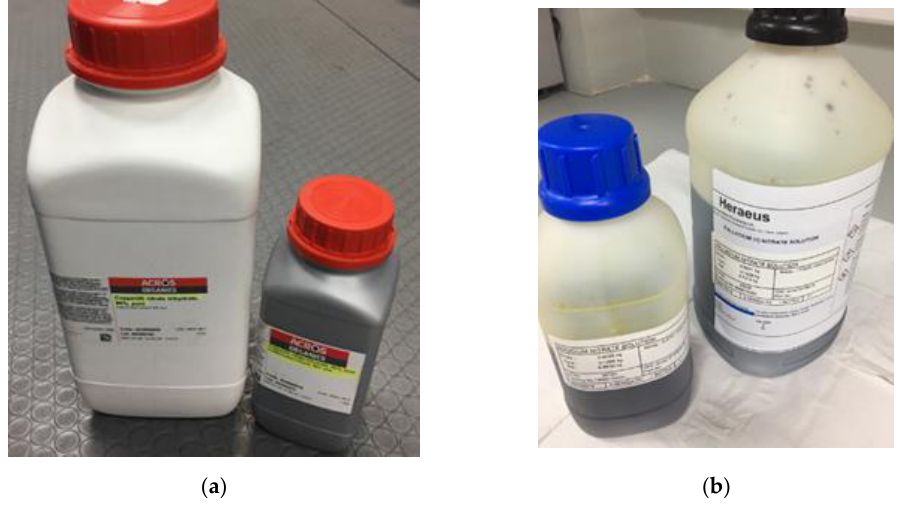
Figure 3. Cu, Pd, Rh metal precursors: ( a ) copper nitrate precursor; ( b ) platinum group metal (PGM, Pd and Rh) nitrate precursor solutions.